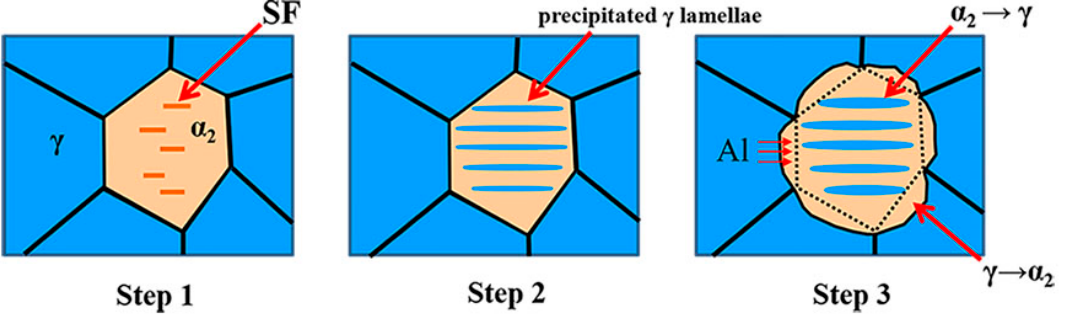
↔ γ proposed in this